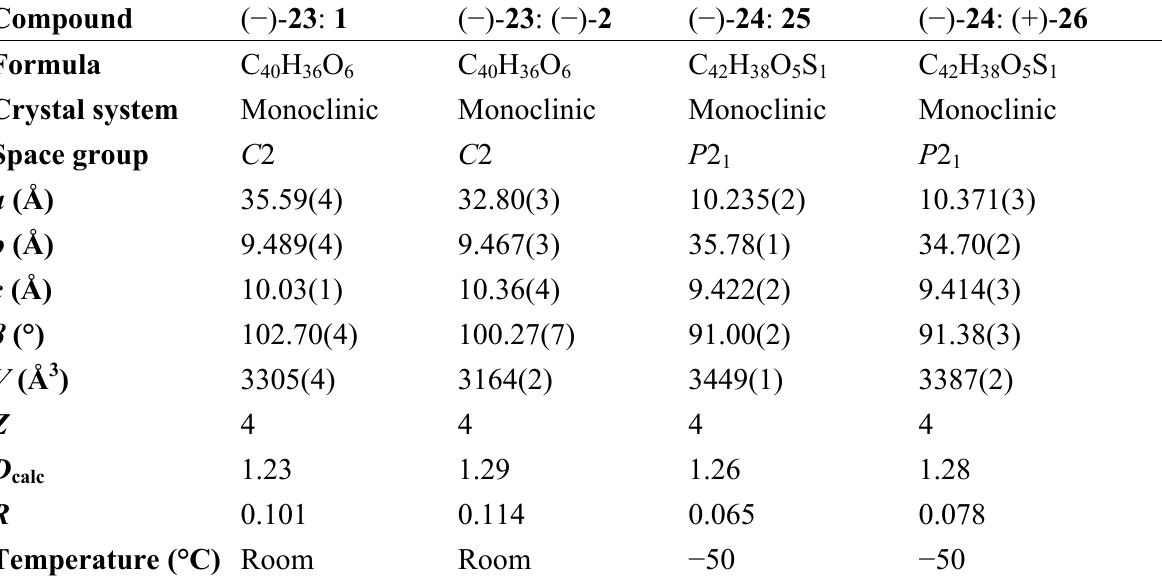
Table 1. Crystallographic data for a 1:1 complex of ( − )- 23 and 1 , a 2:1 complex of ( − )- 23 with ( − )- 2 , a 1:1 complex of ( − )- 24 with 25 , and a 2:1 complex of ( − )- 24 with (+)- 26